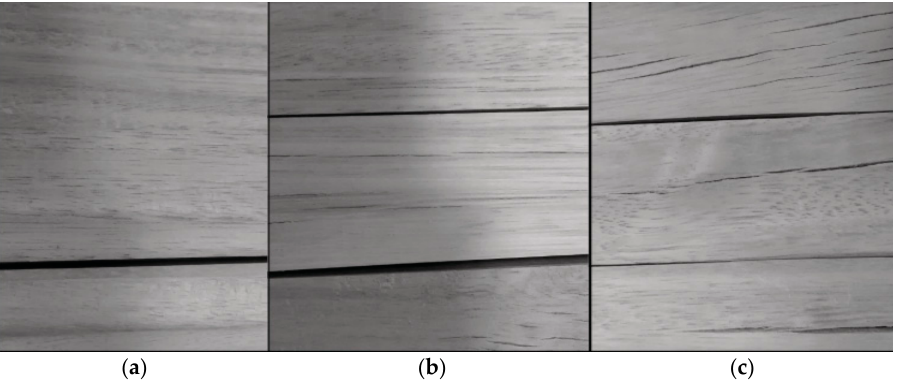
Figure 6. Surface appearance after MW treatment under ( a ) 290 MJ/m 3 , ( b ) 360 MJ/m 3 , and ( c ) 430 MJ/m 3 found by [7].